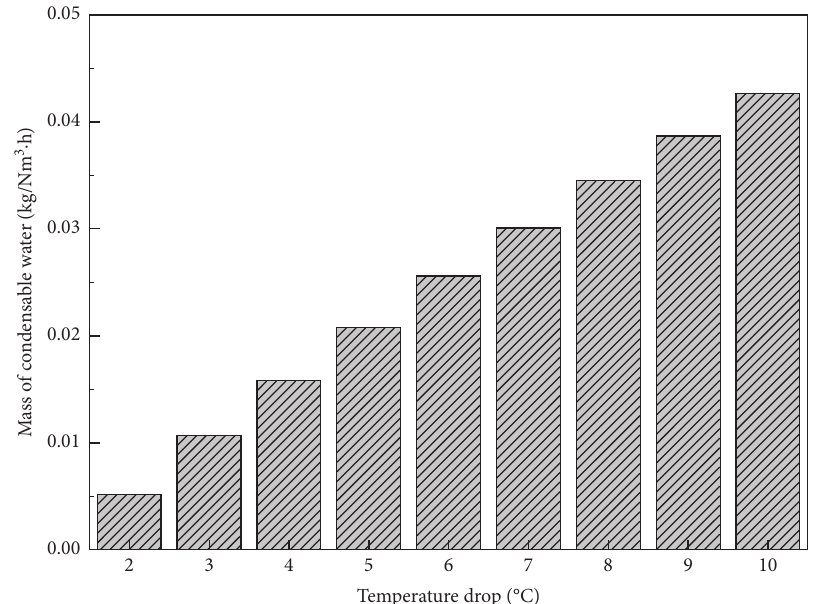
Figure 10: Effect of temperature drop on the mass of condensable water.